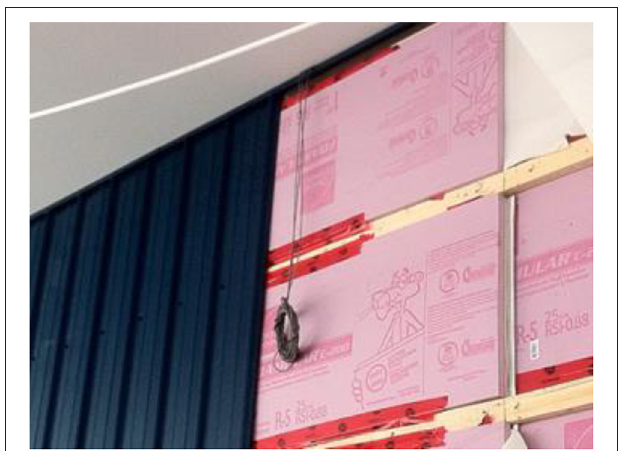
FIGURE 2 | Existing wall selected for retrofit (MacLean and Korn, 2011).